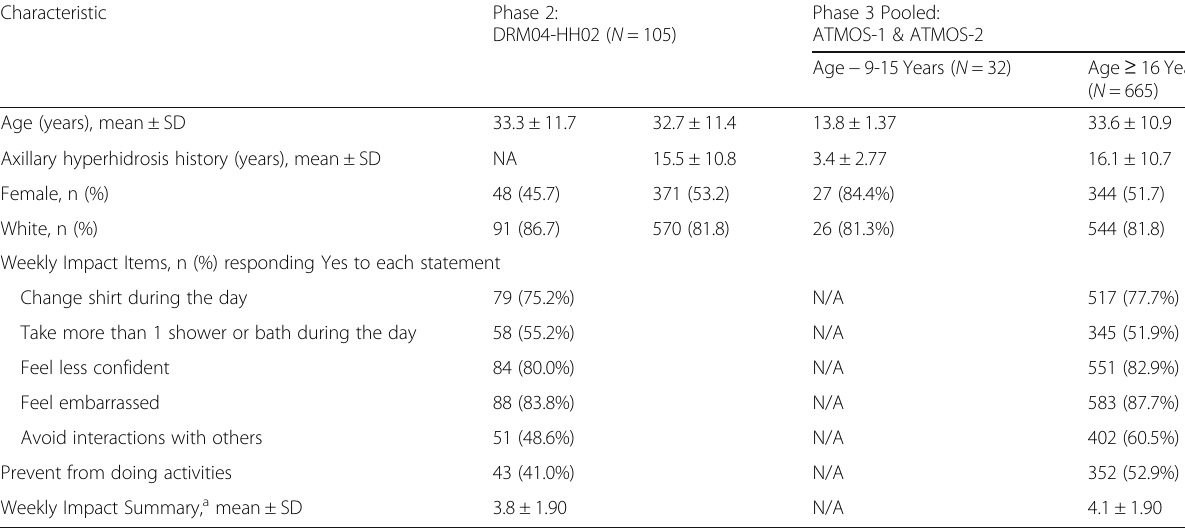
Table 3 Patient Demographic and Hyperhidrosis History Data From Phase 2 and Phase 3 Trials